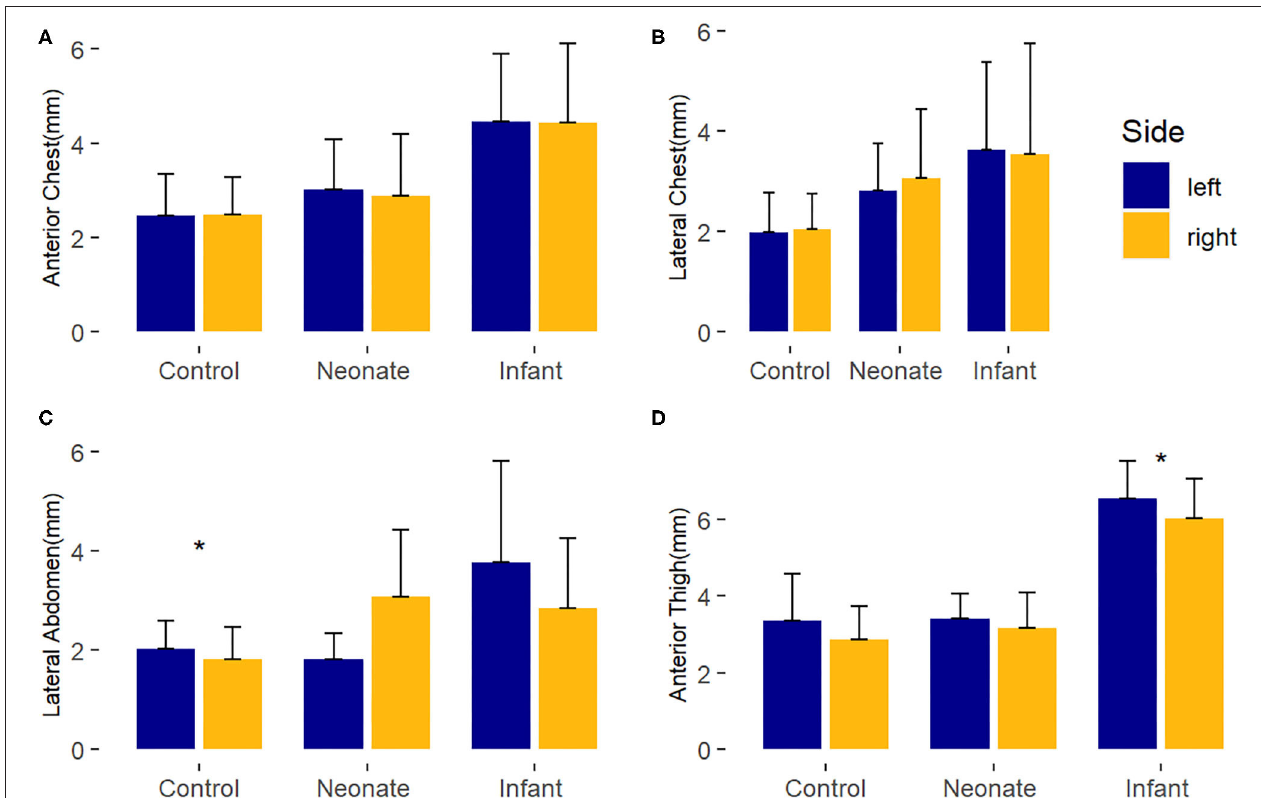
FIGURE 1 | Laterality comparison of right and left-sided average baseline subcutaneous tissue thickness, by body site. *, p < 0.05. (A) Anterior chest; (B) Lateral chest; (C) Lateral abdomen; (D) Anterior